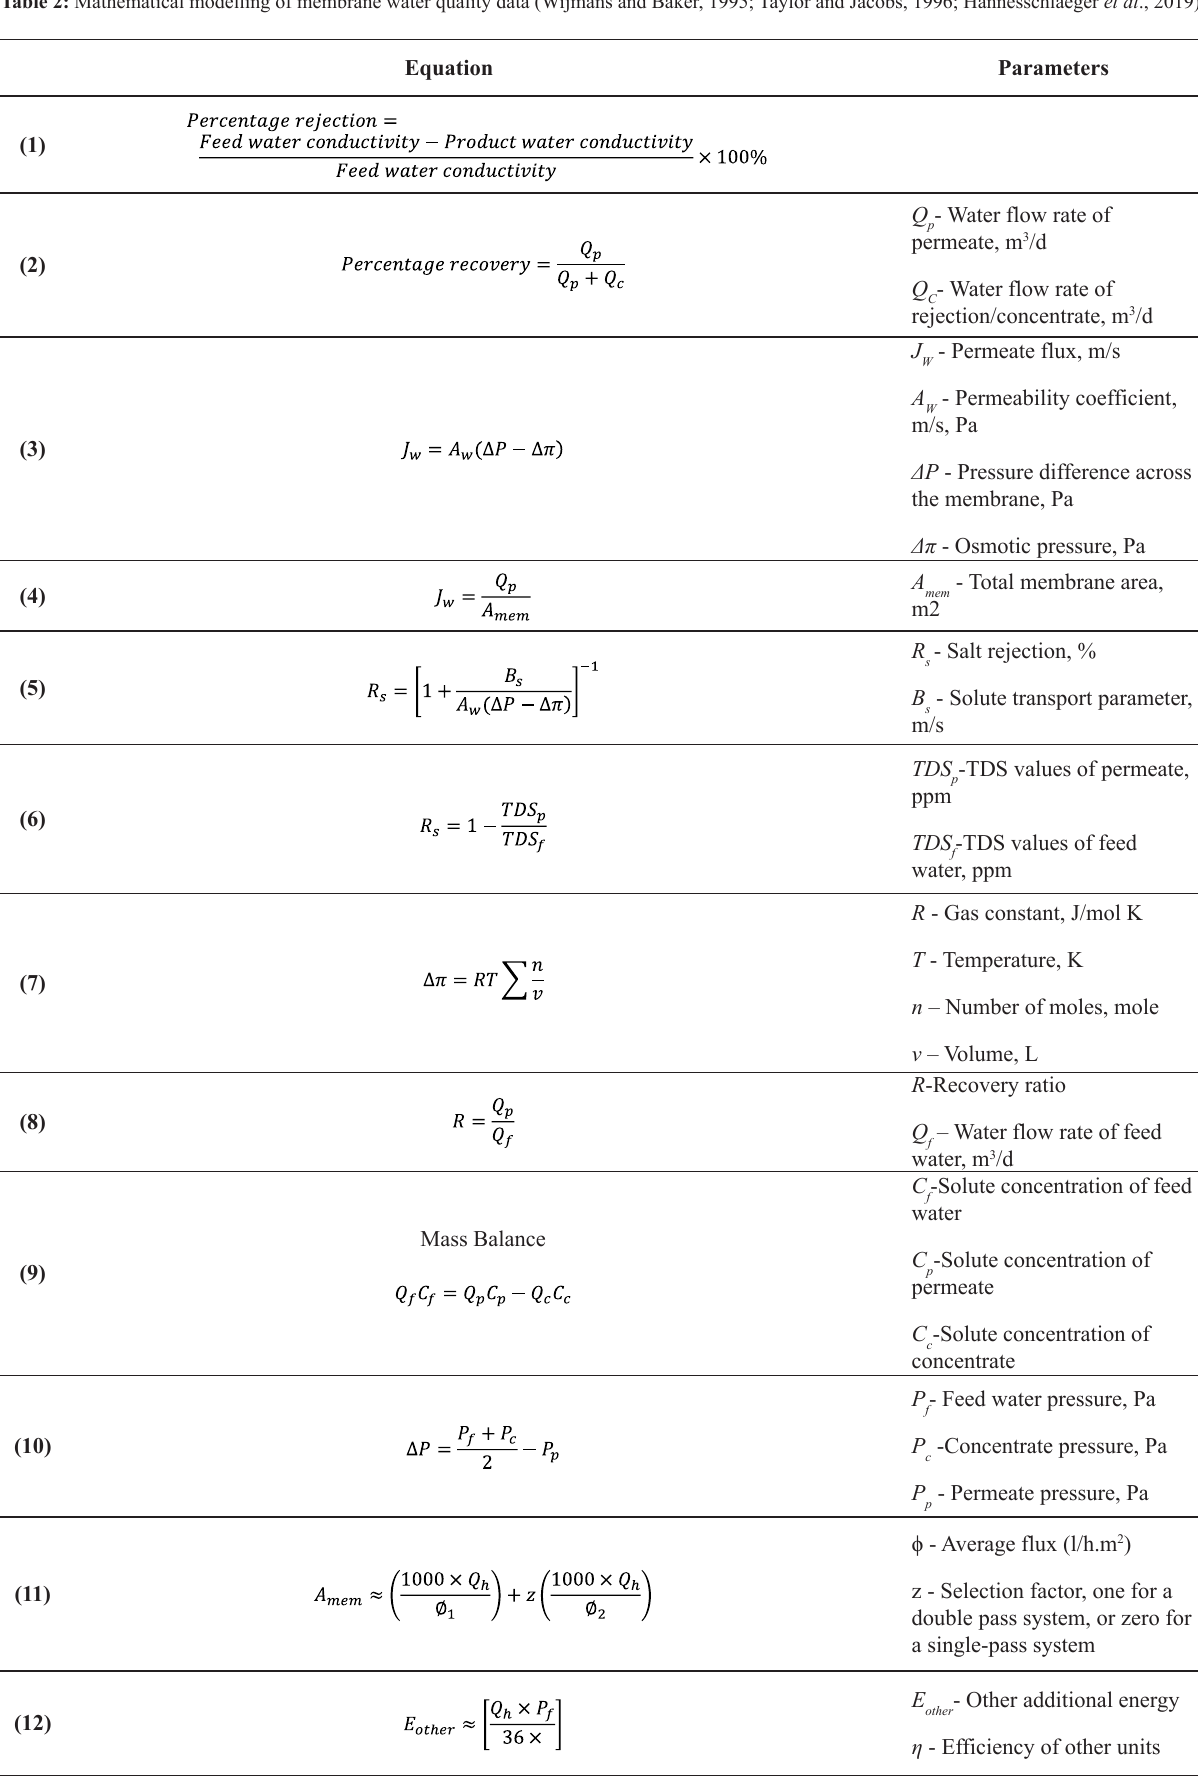
Table 2: Mathematical modelling of membrane water quality data (Wijmans and Baker, 1995; Taylor and Jacobs, 1996; Hannesschlaeger et al .,